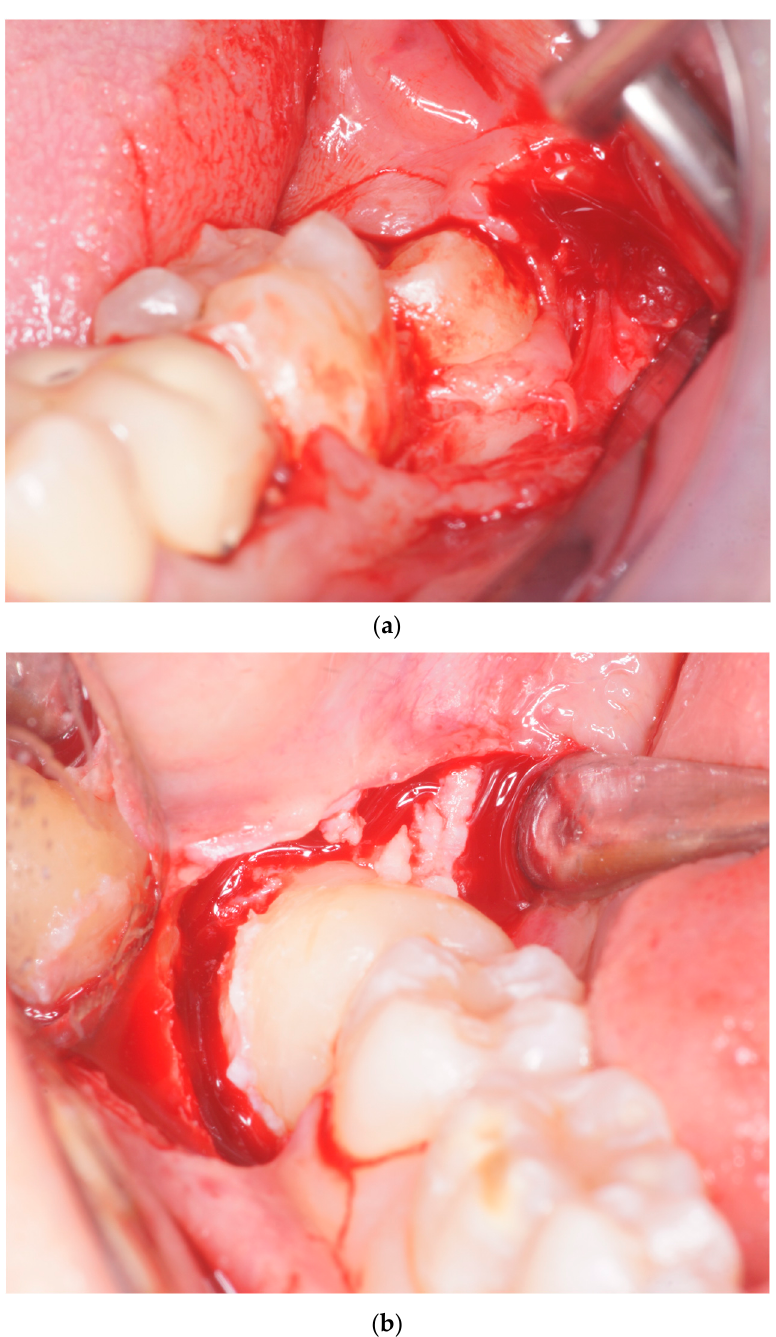
Figure 1. ( a ) Surgical area exposed with envelope flap: crestal incision extended in the retromolar pad continuing intrasulcular to the vestibular aspect of M2. ( b ) Surgical area exposed with triangular flap: distal crestal incision in the retromolar pad with a mesial relieving vertical incision starting from the transition line between the distal third and the central third of the gingival margin of the M2.